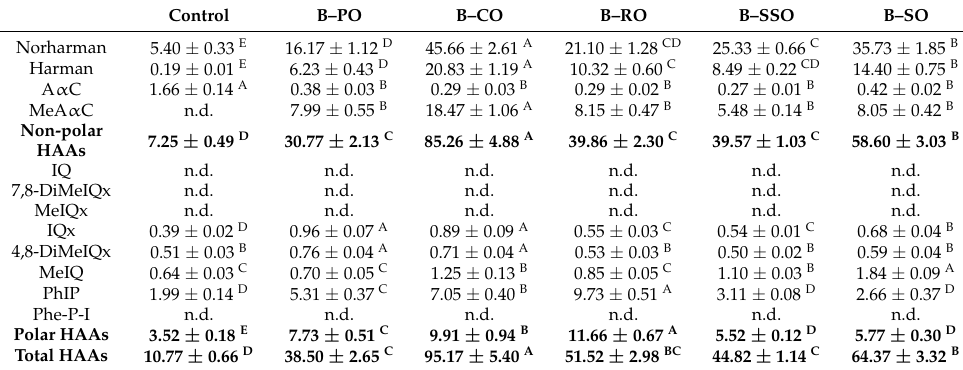
Table 4. Influence of the different vegetable oils on the HAA concentration (ng/g) in pan-fried